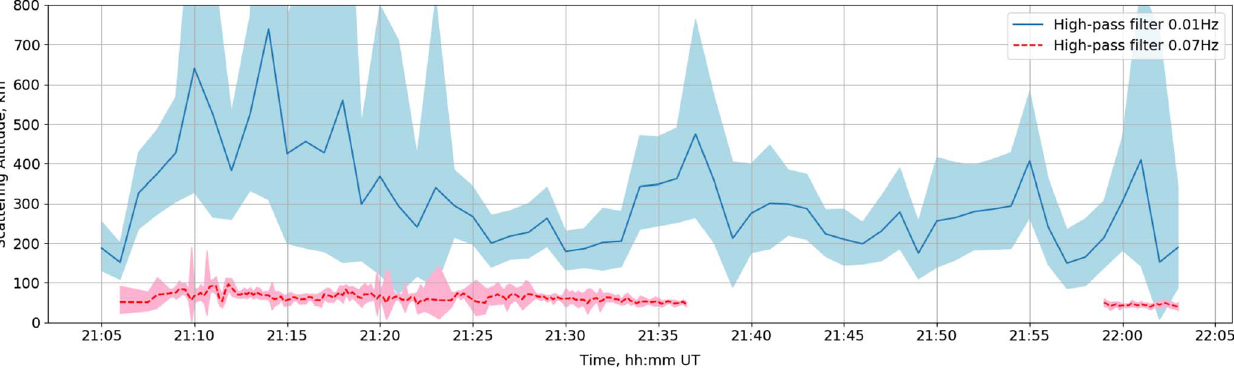
Fig. 10. Scattering altitudes estimated using equation (1), the primary velocities and primary scintillation arc curvatures (blue curve) and the secondary velocities and the curvature of the secondary scintillation arc (red dashed curves).